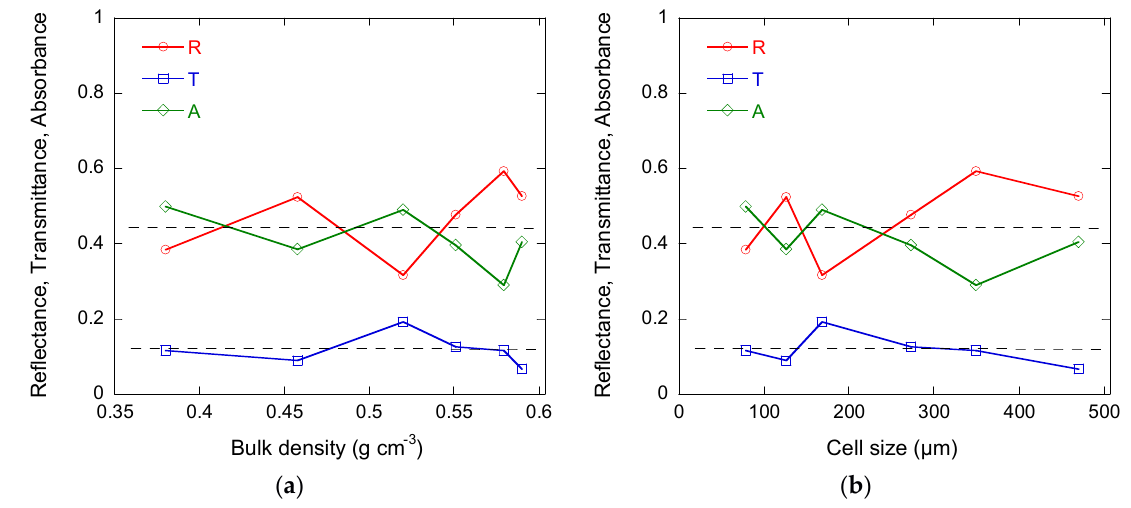
Figure 13. Electromagnetic (EM) properties of cellular carbon monoliths as a function of ( a ) bulk density, and ( b ) cell size: reflectance ( R ), absorbance ( A ), and transmittance ( T ) at 30 GHz. The dashed lines are just guides for the eye and show the main trends. The measurement error is at the level of 3–5%.